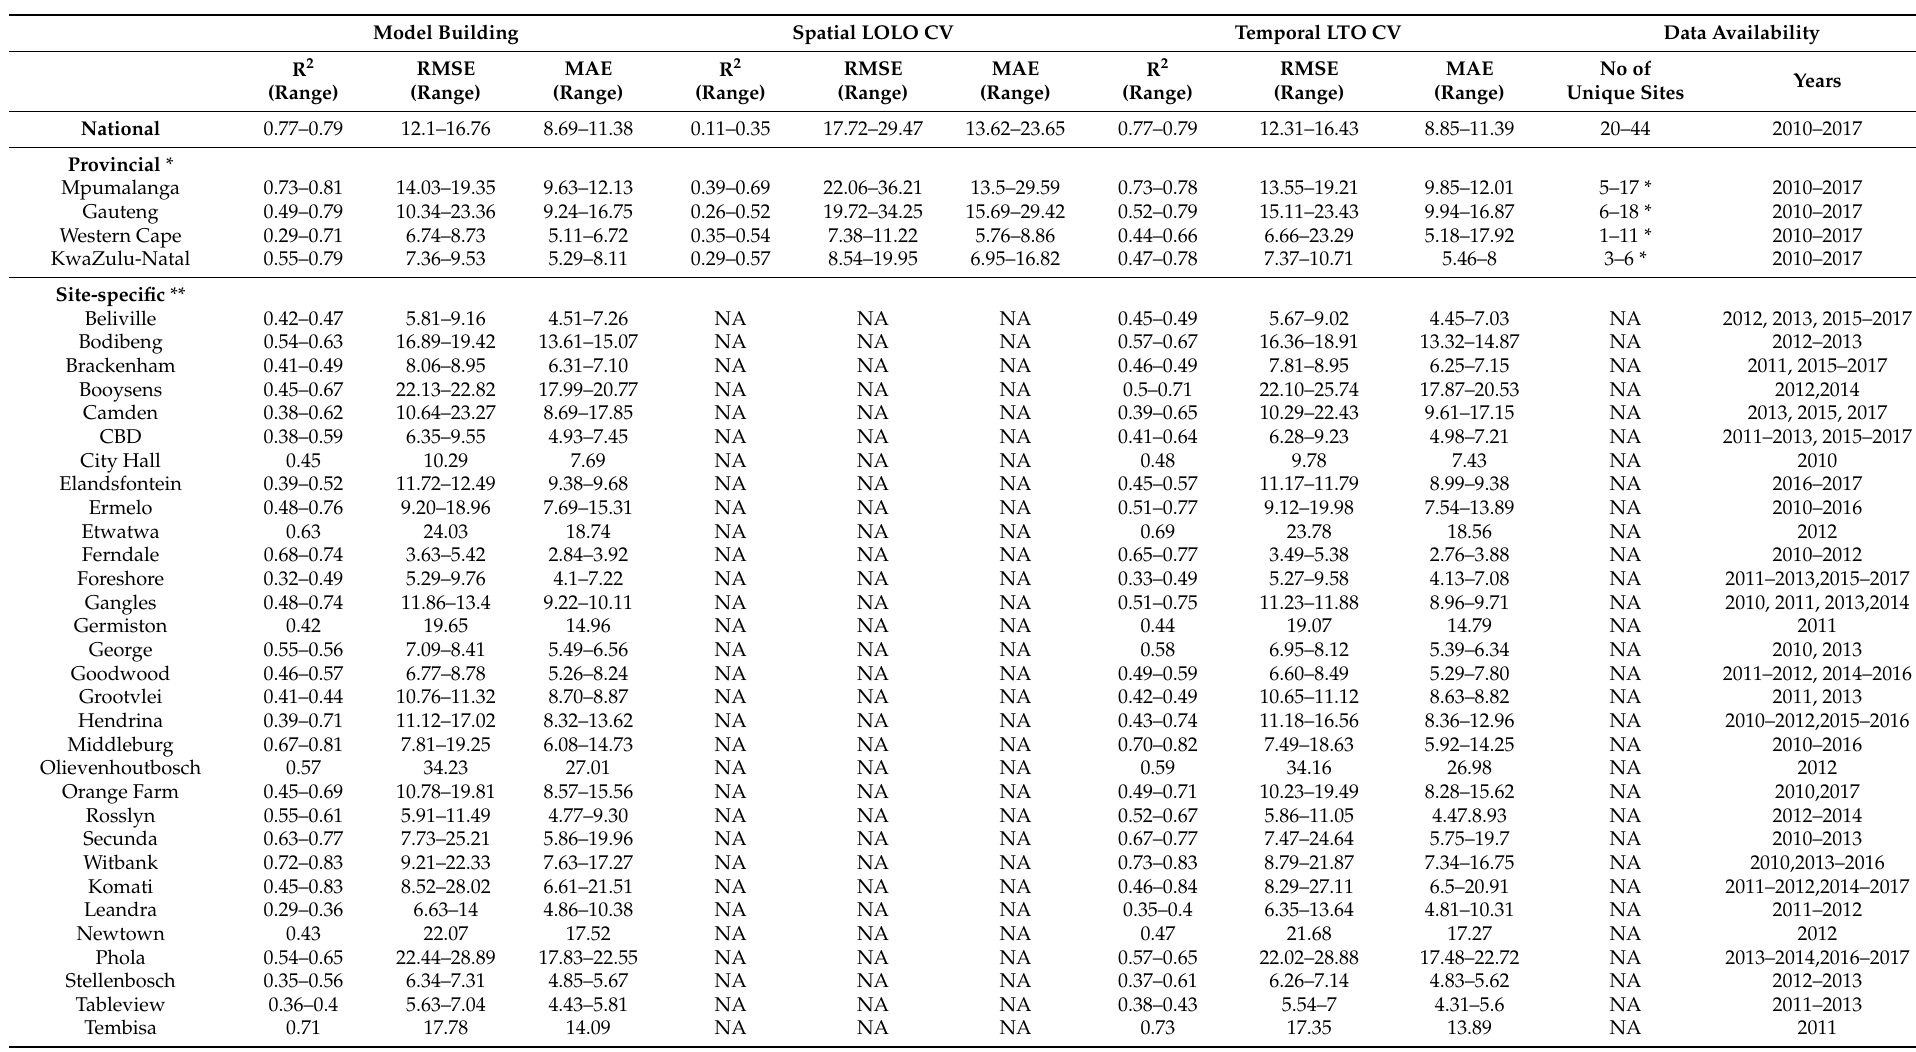
Table 2. Summary of model performance statistics over the period 2010–2017 for the national, provincial and site-specific models showing the range of R 2 , root mean squared error (RMSE) and mean absolute error (MAE) for the years